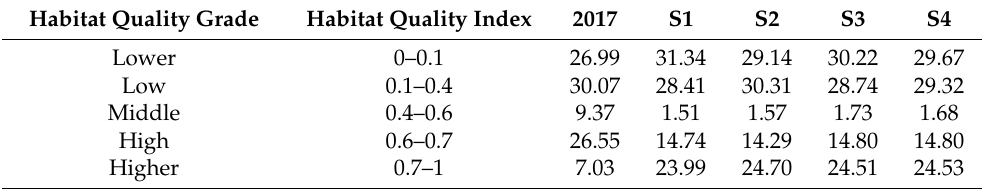
Table 8. Habitat quality grade classification and area proportion in2017 and 2030 (%).